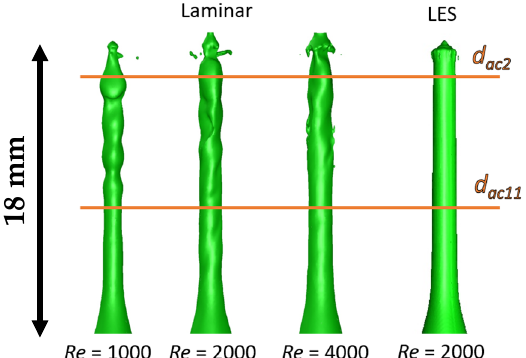
Figure 11. The air-core surface from laminar simulation and LES (right).